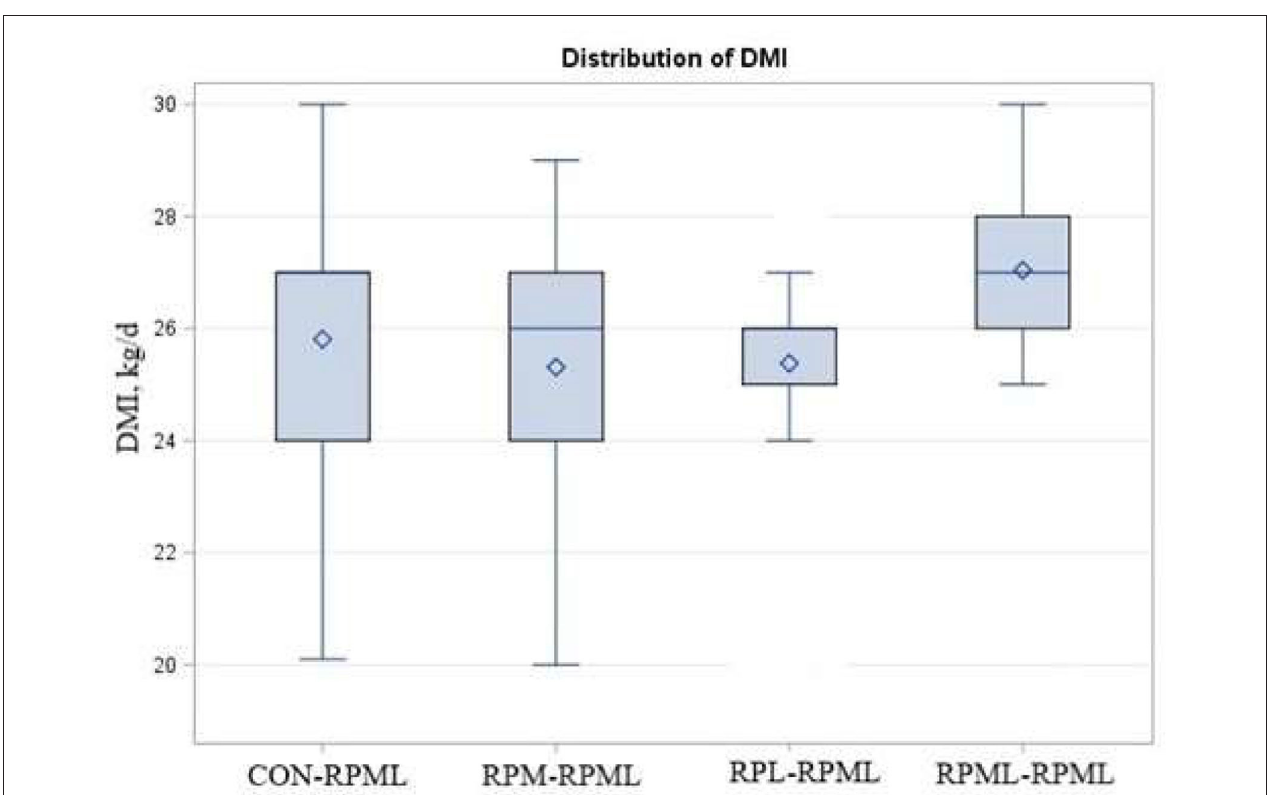
FIGURE 1 | Effect of supply ruminally protected Met and Lys to transition and milking dairy cows on dry matter intake. Values are means; standard errors represented by vertical bars.